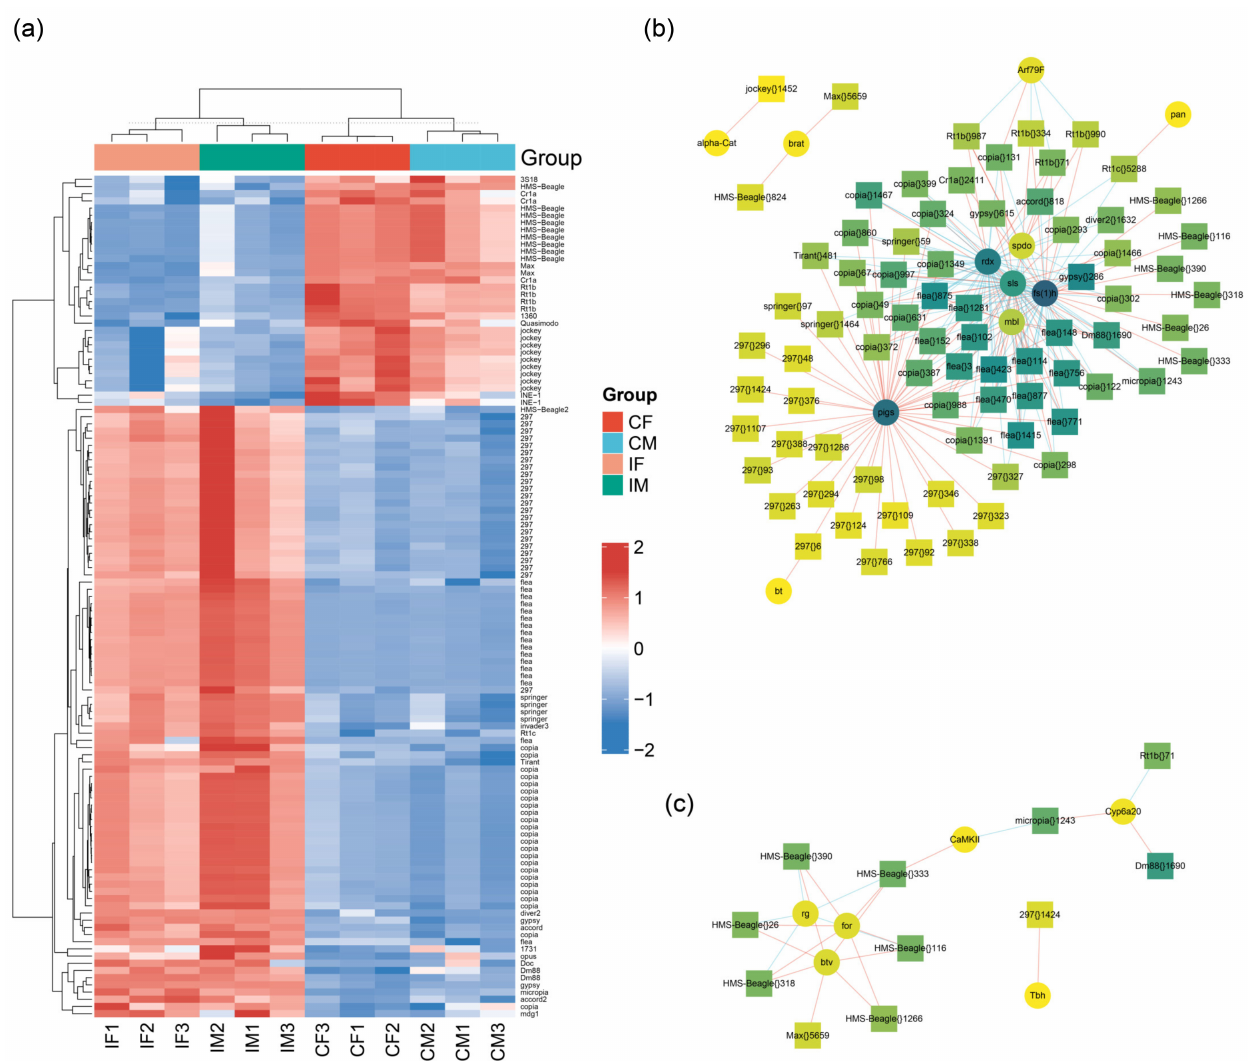
Figure 8. Differentially expressed transposons and co-expressed mRNAs. ( a ) Heat maps of differ- entially expressed transposon (baseMean > 500) expression level in ISWI mutant lines. Network of transposons associated with co-expressed mRNAs associated with growth and development ( b ) or chromatin remodeling ( c ). The pink line means positively correlated, and the blue line means negatively